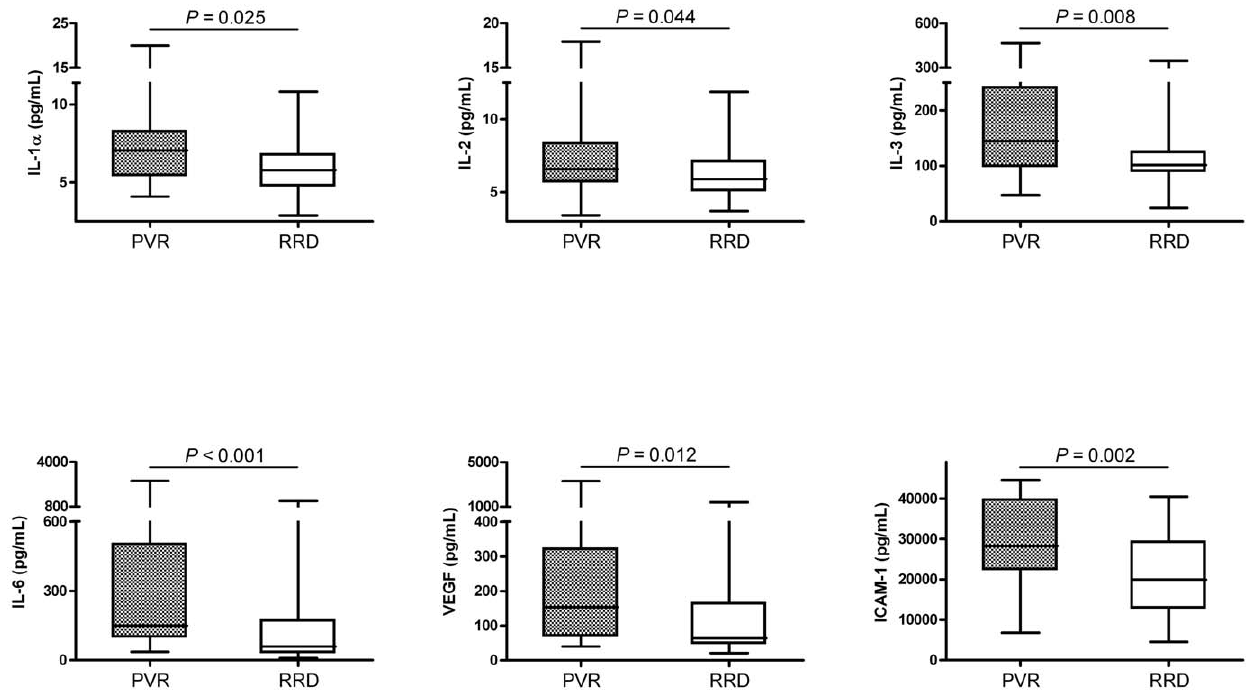
Figure 1. Box-and-whisker plots of significantly elevated cytokine levels in patients with primary rhegmatogenous retinal detachment. A multiplex immunoassay was used to determine 29 different cytokines in subretinal fluid samples obtained during scleral buckling surgery for rhegmatogenous retinal detachment. Patients who developed a redetachment due to postsurgical PVR within 2 K months after reattachment surgery ( n =21, ‘PVR’ group) were compared with controls who had an uncomplicated retinal detachment during the overall follow-up period ( n =54, ‘RRD’ group). Levels of IL-1 a , IL-2, IL-3, IL-6, VEGF, and ICAM-1 were significantly higher ( P , 0.05) in patients who developed postoperative PVR than in patients with an uncomplicated postoperative course. After correction for possible confounding variables including preoperative PVR, duration of retinal detachment, and macular involvement, these factors remained significantly different between both groups (see text). Box : lower and upper quartiles; horizontal line : the median. Abbreviations: PVR=proliferative vitreoretinopathy; RRD=rhegmatogenous retinal detachment; IL=interleukin; VEGF=vascular endothelial growth factor; ICAM-1=intercellular adhesion molecule-1.